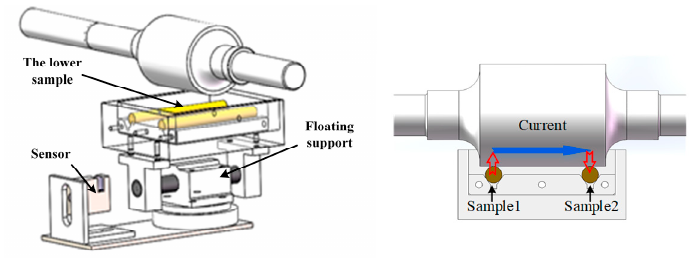
Figure 2. Schematic diagram of sample installation.